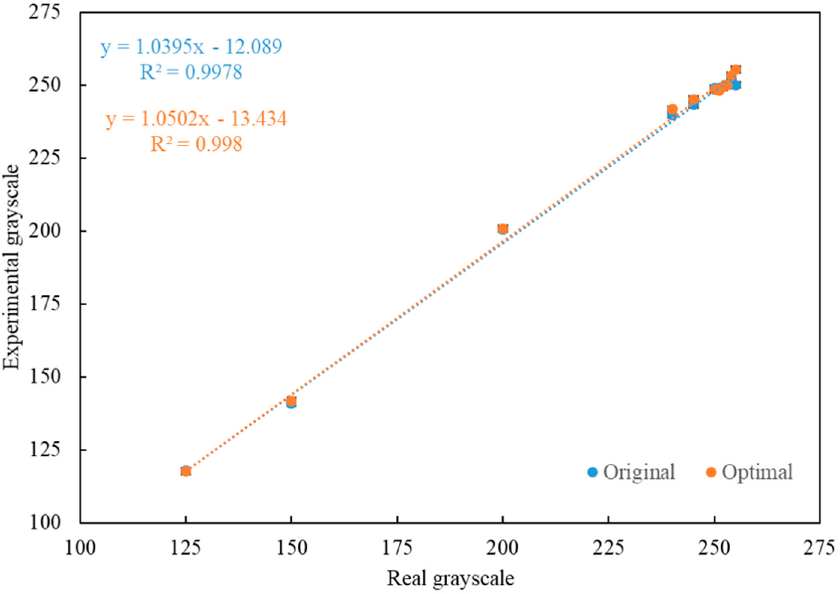
Figure 6. The relationship between the original design and the optimal design of the self-made simulated rapid test strip.